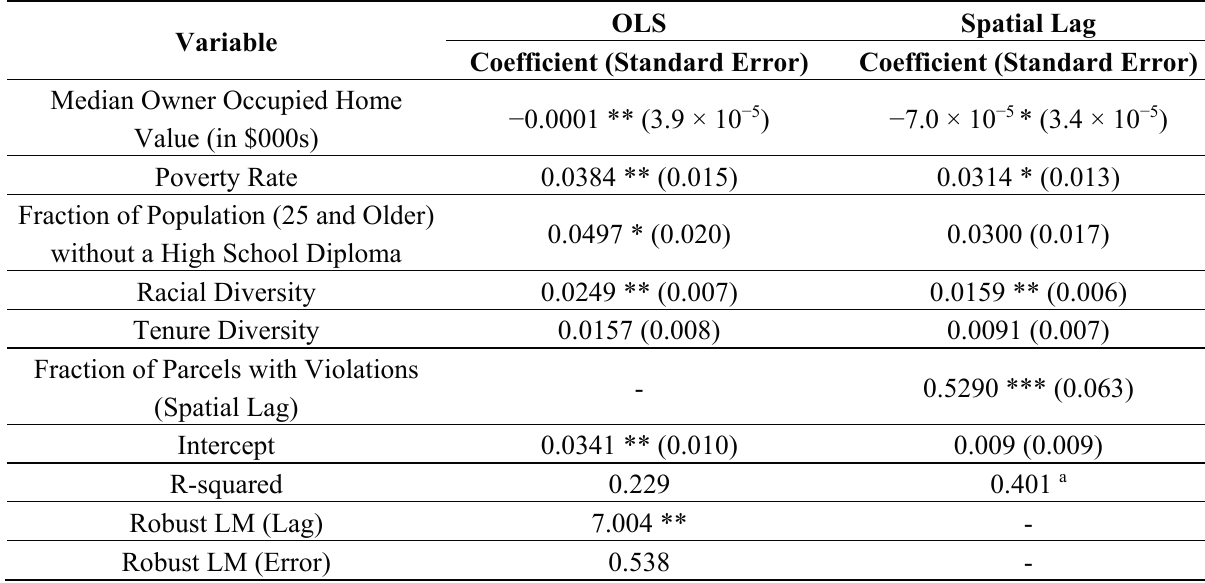
Table A1. Regression estimation results, dependent variable = fraction of parcels committing new code violations in